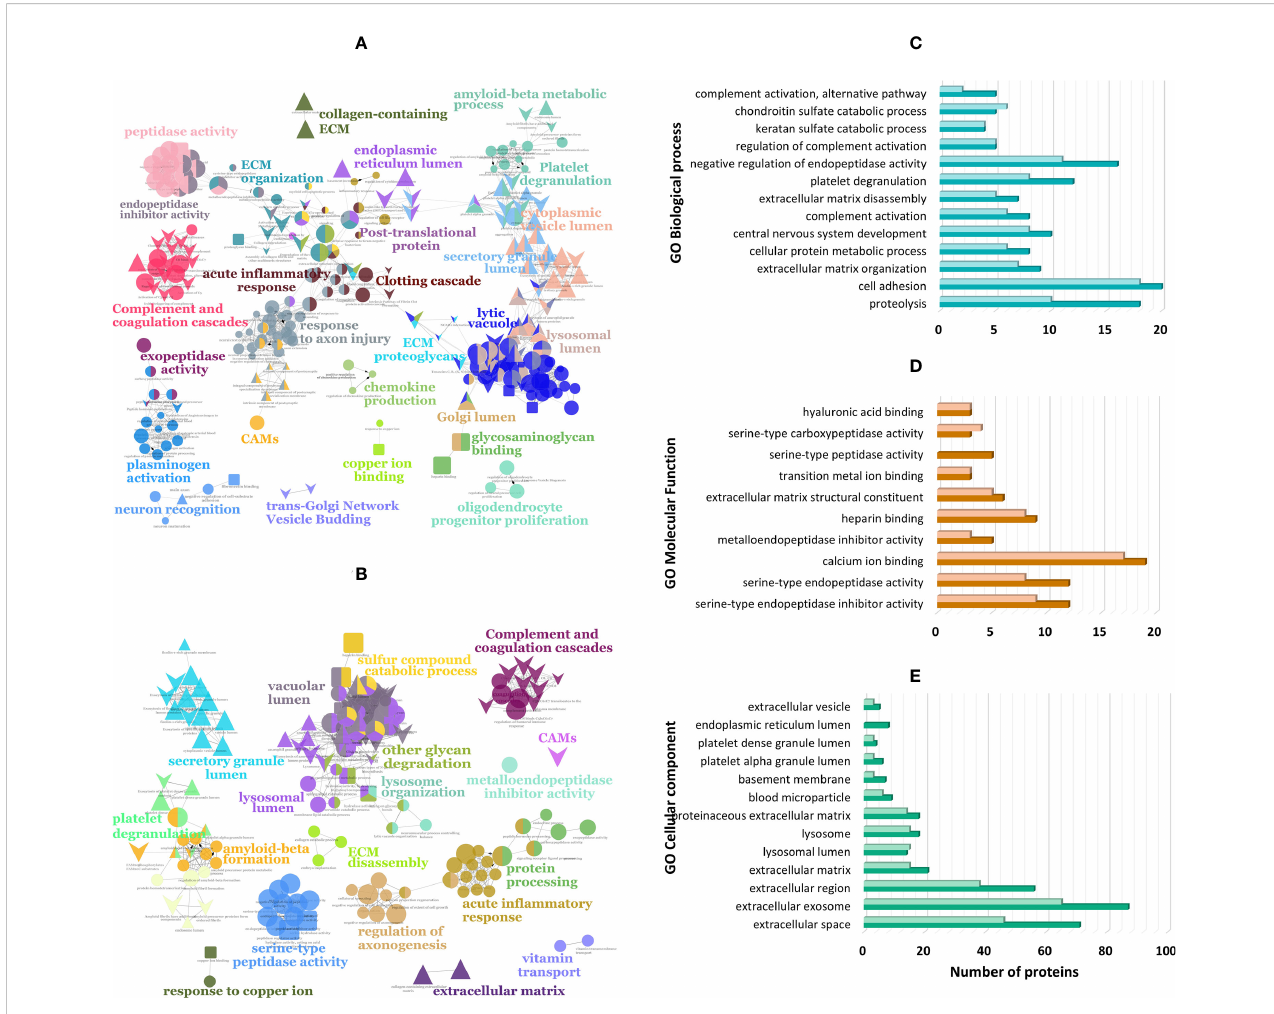
FIGURE 2 Functionally grouped network of enriched categories generated in ClueGO (Cytoscape app) for the proteins found differentially expressed in proliferative diabetic retinopathy (PDR) compared to patients with (A) epiretinal membranes (ERM) and with (B) dry age-related macular degeneration (dry AMD). These proteins were also classi fi ed according to gene ontology (GO) terms using DAVID Bioinformatics tool and ClueGo for (C) biological process, (D) molecular function, and (E) cellular component with the darkest colors representing proteins differentially expressed in PDR versus ERM, and lightest colors representing proteins differentially expressed in PDR versus dry